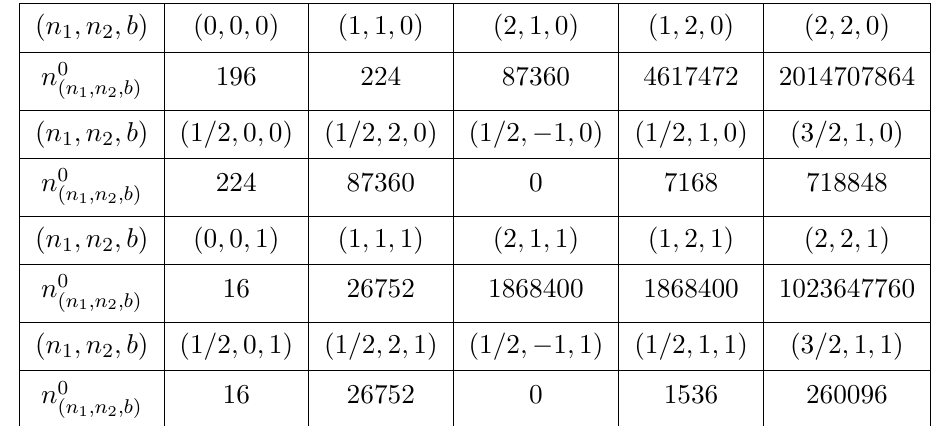
Table 11 . 2 A orbifold, non-standard embedding, with single Wilson line. Shift is given by, (cid:13) =